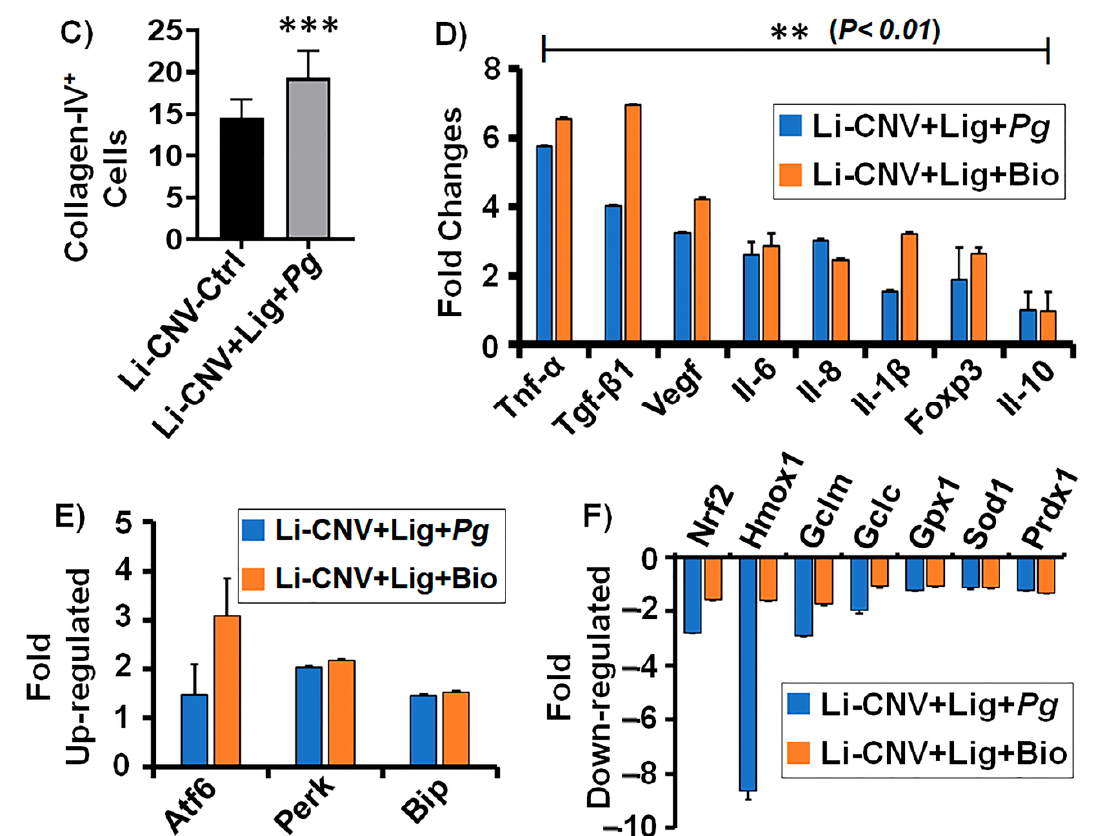
Figure 5. Increased choroidal/retinal vasculogenesis, oxidative stress, inflammatory mediators, and decreased antioxidants genes in the retinae of AMD+PD mice. ( A – C ) Immunofluorescence staining shows more Col-IV (angiogenic/vascular marker) in the AMD+PD mice retinae and choroidal region compared to CNV control ( A ). ( B ) white arrows indicate newly formed blood vessels. Note: Refer to Figure S4 for another set of representative images. ( C ) Quantification analysis shows increased Col-IV + cells in Li-CNV+Lig+ Pg -infected retinae, relative to Li-CNV group. Two groups were compared, and data were analyzed using unpaired Student’s t test ( n = 6; *** P < 0.001 ). (Scale bar: 20 µm). ( D – F ) qPCR shows up-regulation of pro-inflammatory ( D ), oxidative stress ( E ) genes and down-regulation of anti-inflammatory mediators ( D ) and antioxidants ( F ) in Li-CNV+Lig+ Pg, and Li-CNV+Lig+Bio relative to the average of CNV and CMC controls. Fold change in gene expression normalized with internal controls, and ±1.5 fold was considered significant ( n = 6, ** P < 0.01 ).